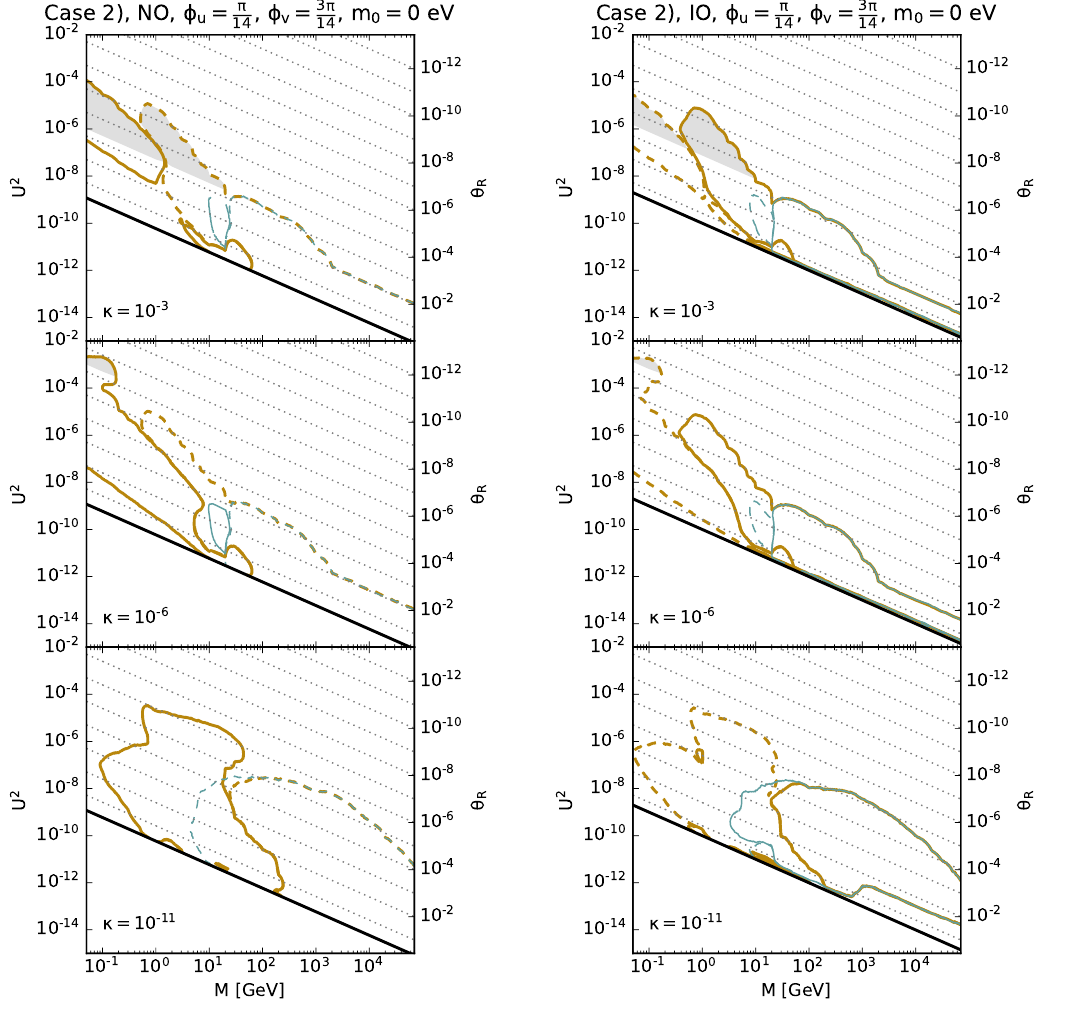
Figure 34 . Case 2) Range of total mixing angle U 2 consistent with the observed BAU for heavy neutrino masses between 50 MeV and 70 TeV, as presented in figure 19. The three rows correspond to different values of κ , κ ∈ { 10 − 3 , 10 − 6 , 10 − 11 } , respectively. The vanishing and thermal initial conditions are shown by the ochre and turquoise lines, respectively. The continuous (dashed) lines indicate positive (negative) values of the BAU. The grey shaded areas show the regions in which a condition like the one in eq. (3.69) is no longer satisfied. The angle θ can be read R